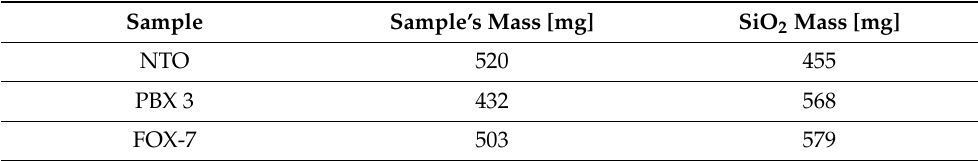
Table 6. SSRT test